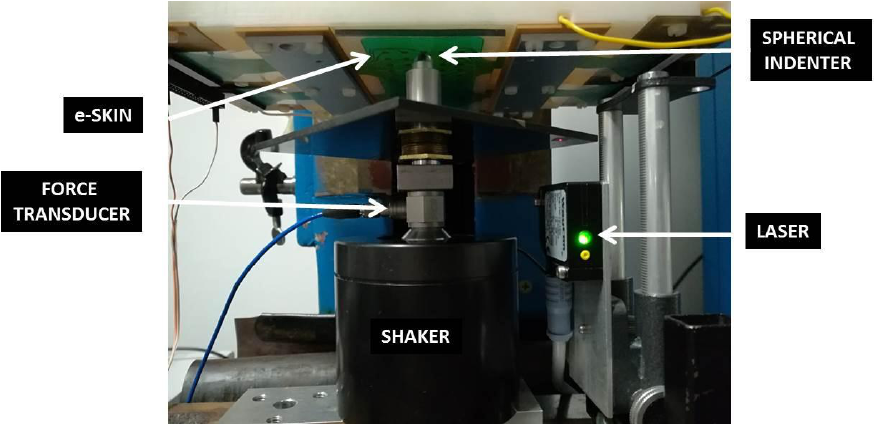
Figure 12. Experimental equipment for e-skin validation.